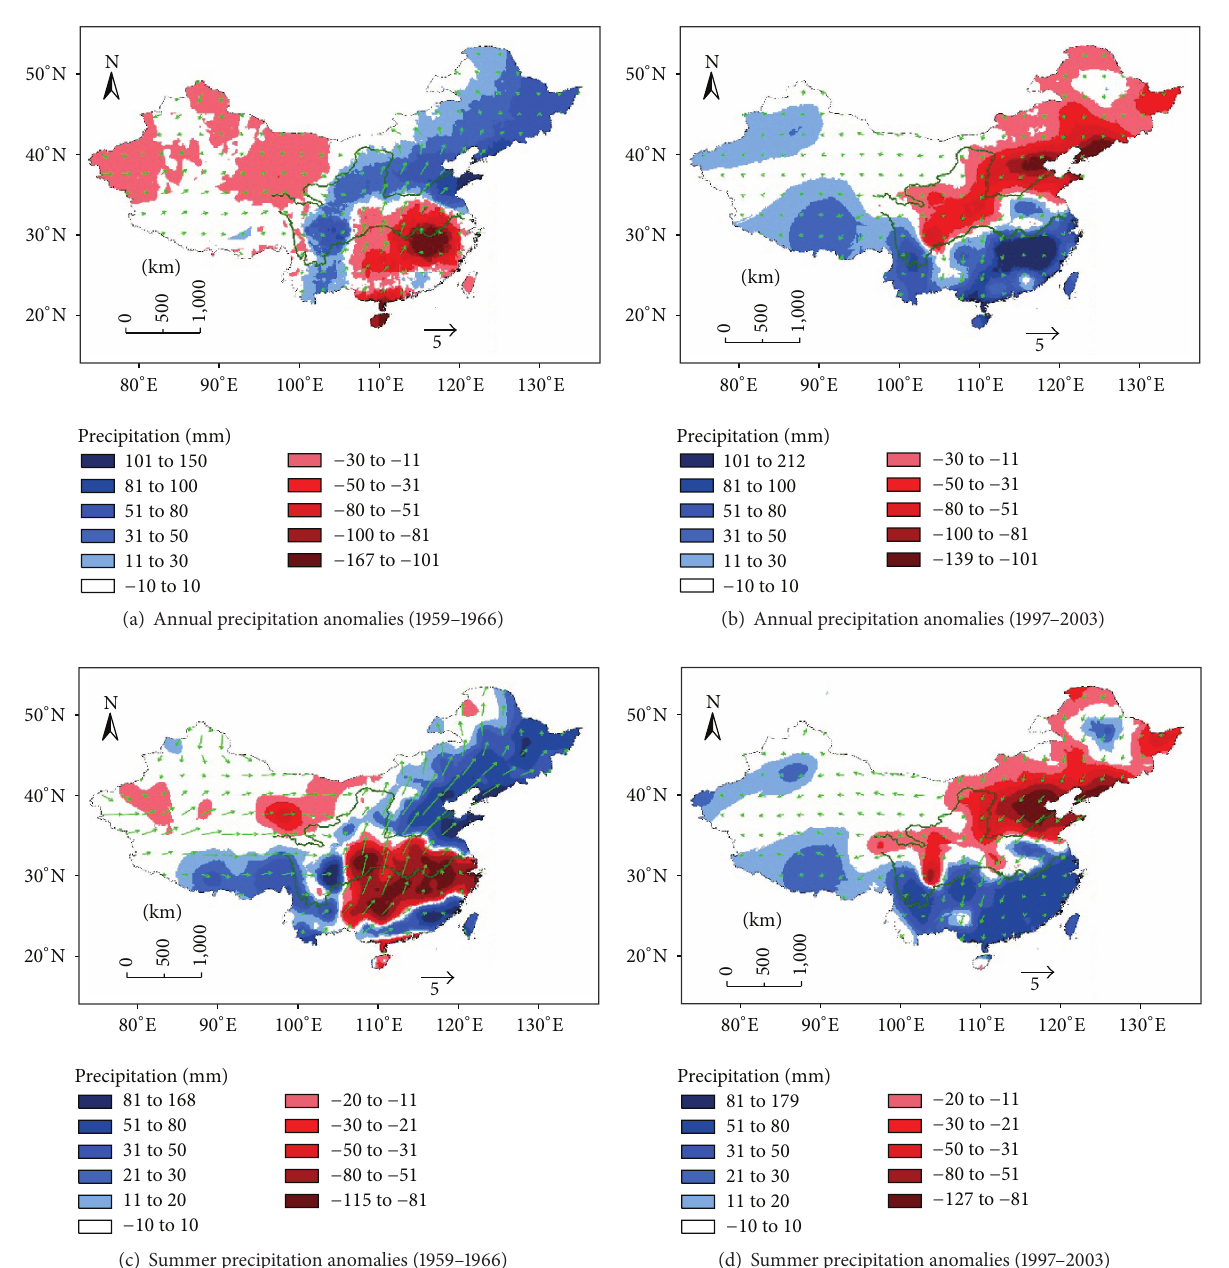
Figure 4: Comparison of the annual and summer mean precipitation anomalies in China during the periods of 1959–1966 and 1997–2003.